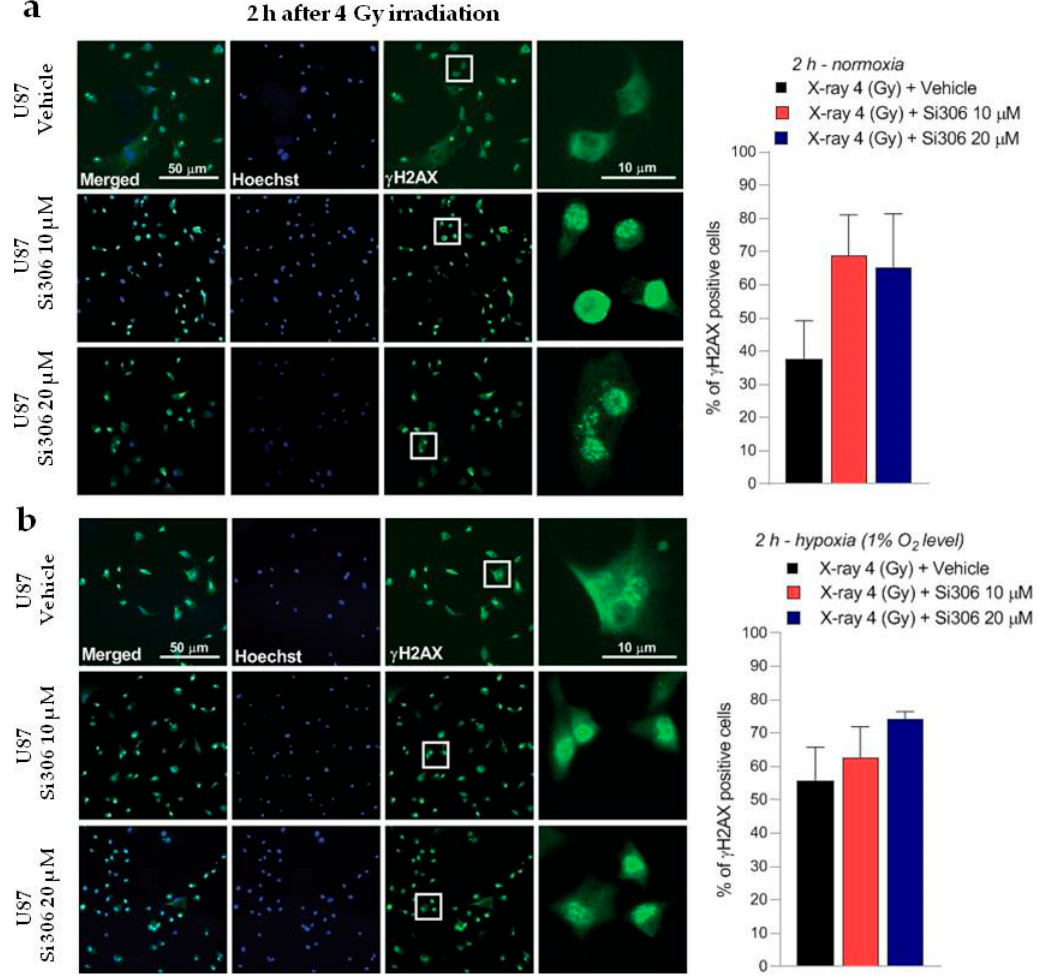
Figure 7. Representative pictures with inserts (white squares) and quantification of U87 positive cells for γ H2AX performed 2 h after 4 Gy irradiation in normoxia ( a ) and hypoxia ( b ) Data are mean ± SD of n = 3 independent experiments (F normoxia = 5.787, p -value < 0.0329; F hypoxia = 4.048, p -value < 0.0557. One-way ANOVA with Holm–Šídák post-hoc test).